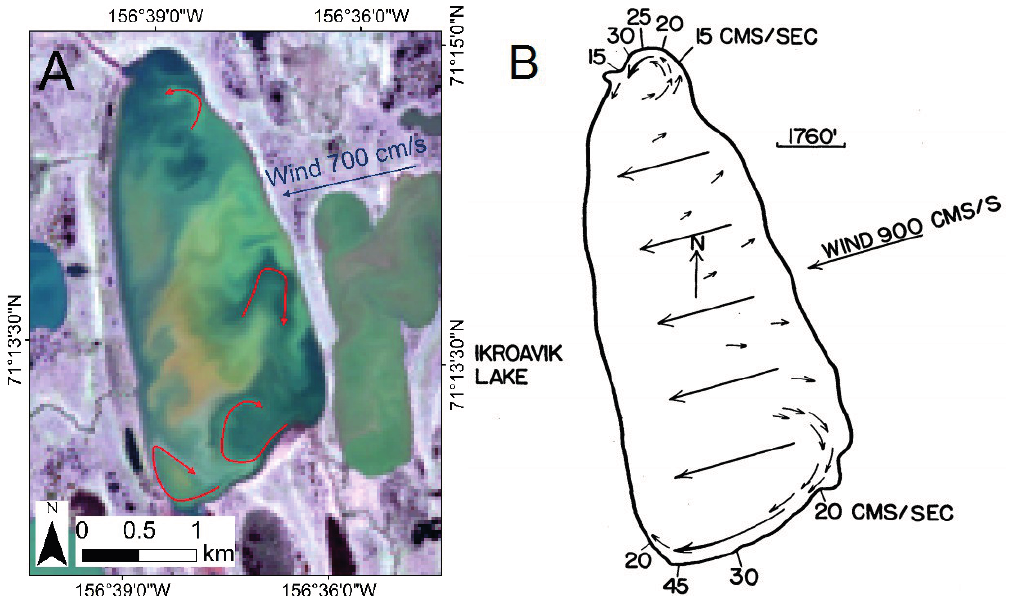
Barrow, Alaska on 10 July 2013 ( A ) with flow patterns determined by dye and float experiments by Carson and Hussey [12] ( B ) (Figure B adapted from Carson and Hussey [12] with permission from The Chicago University Press).